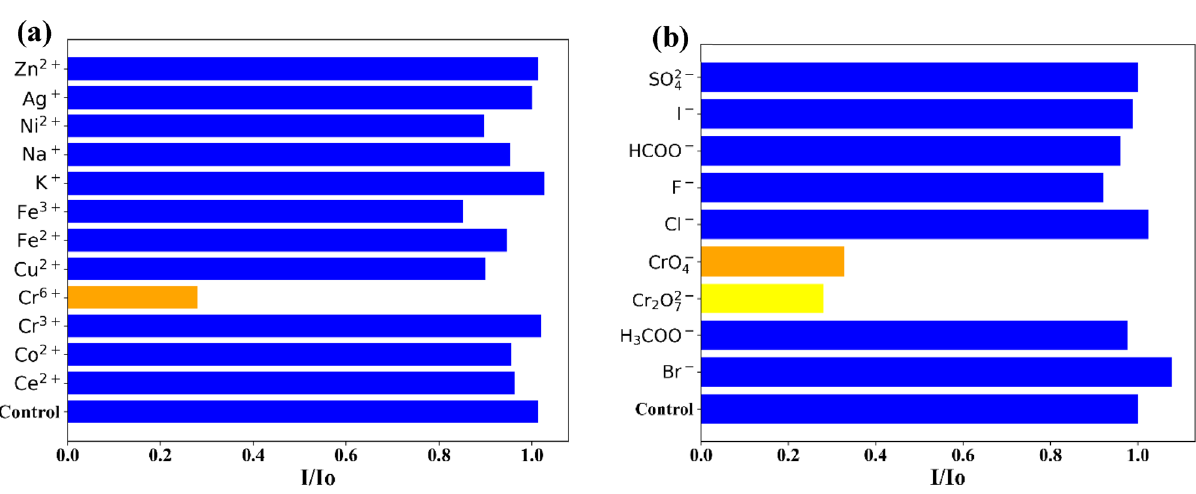
Figure 8. Selectivity of the N-CQDs based